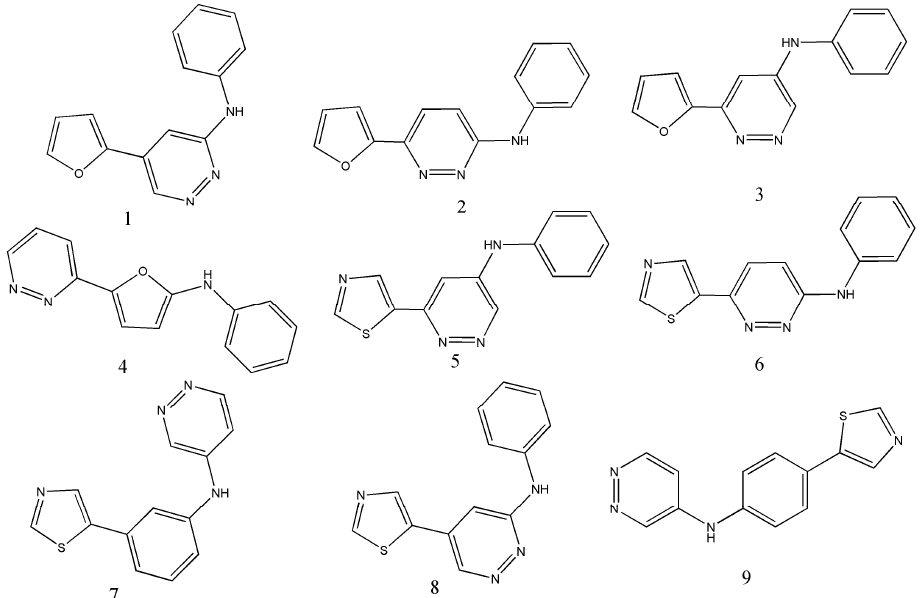
Figure 1. Examples of new anti-breast cancer leads suggested in the mtk-QSAR modeling study by Speck-Planche et al. [55].